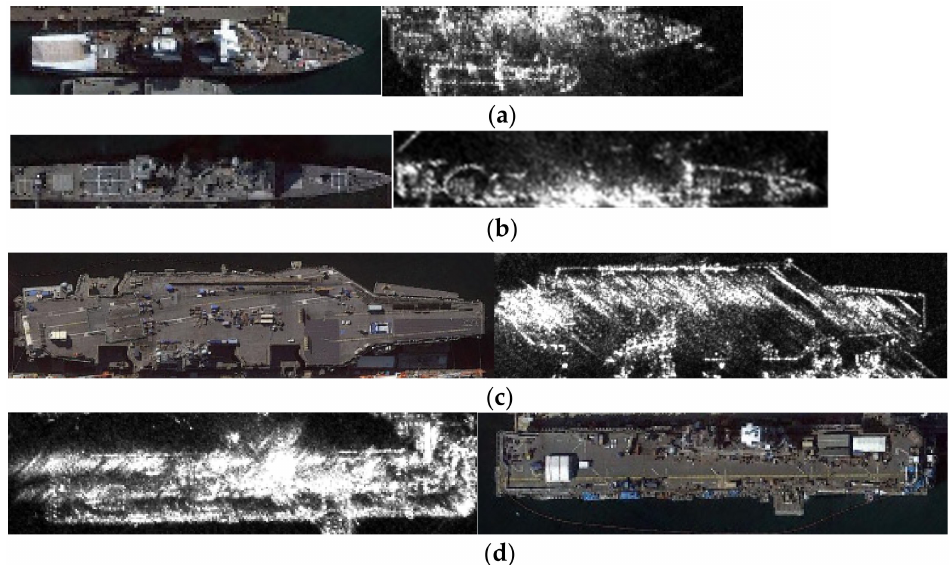
Figure 4. Examples of samples from dataset 3. ( a ) Displays paired optical-SAR object slices for a ship with type 1. ( b ) Displays paired optical-SAR object slices for a ship with type 2. ( c ) Displays paired optical-SAR object slices for a ship with type 3. ( d ) Displays paired optical-SAR object slices for a ship with type